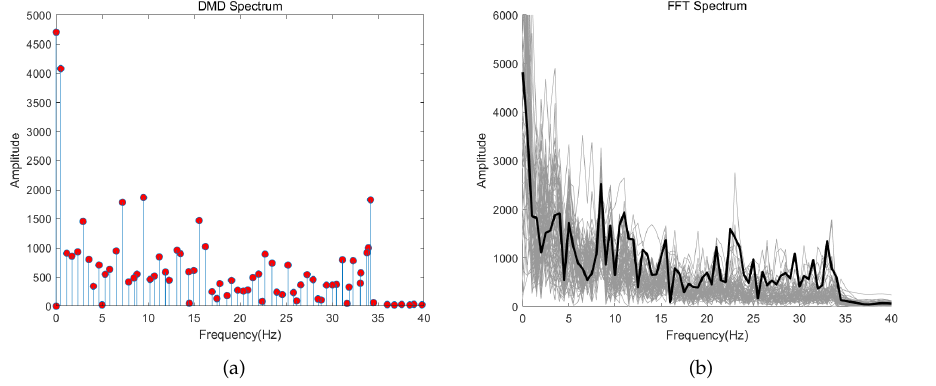
Figure 3. ( a ) DMD spectrum. ( b ) the FFT spectrum (gray lines for all 64 channels and bold black line for the average). The DMD spectrum qualitatively resembles the power spectrum as computed by FFT. (Take the recording in session 2 of subject 3 in the monitoring error-related potentials dataset as an example.)